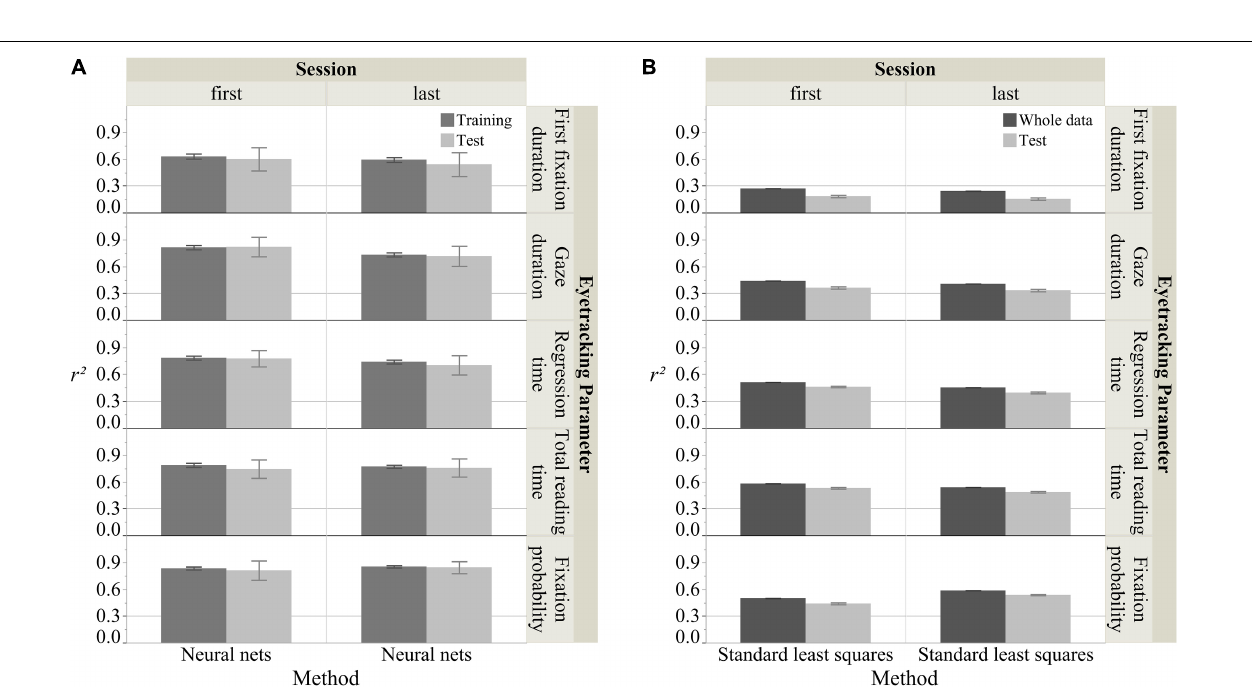
FIGURE 4 | Fit scores for different models and measures. For neural nets (A) , R 2 s from 100 iterations were averaged for both the training and test sets. For standard least squares regressions (B) , the R 2 for the whole data set and the mean R 2 s from 100 iterations for the test sets were calculated. Nine predictors ( lineNo. , wordNo. , wl , logf , on , hfn , odc , cvq , and sonscore ) and five response parameters (first fixation duration, gaze duration, regression time, total reading time, and fixation probability) were included in analyses. Each error bar is constructed using one standard deviation from the mean.